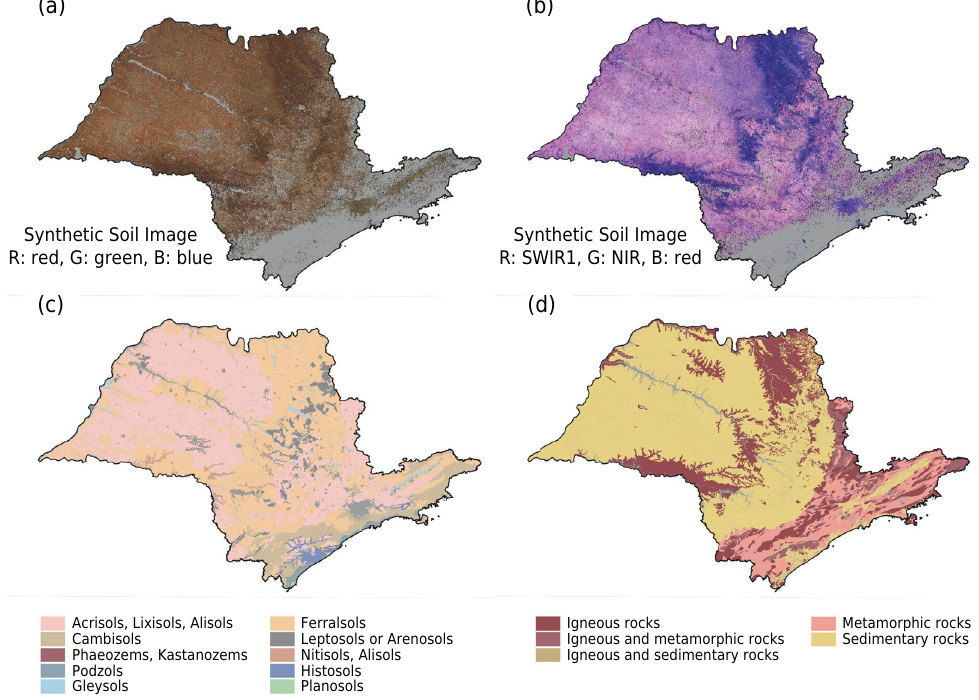
Figure 2. a) Synthetic Soil Image (SYSI) in true-color composition; b) SYSI in false-color composition; c) Main soil taxonomic classes (scale 1:500.000 from Rossi (2017); d) Rock types (IPT - Instituto de Pesquisas Tecnológicas, 1981). Gray color indicates unmapped soil reflectance in SYSI images and the absence of information in soil and lithological maps. The readers are referred to figure 1 for spatial